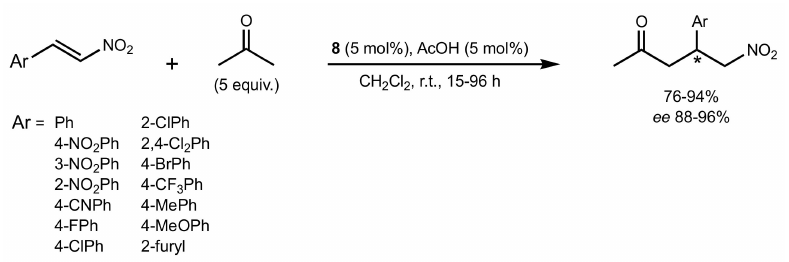
Scheme 4. The Michael addition of acetone to nitrostyrenes catalysed by 8